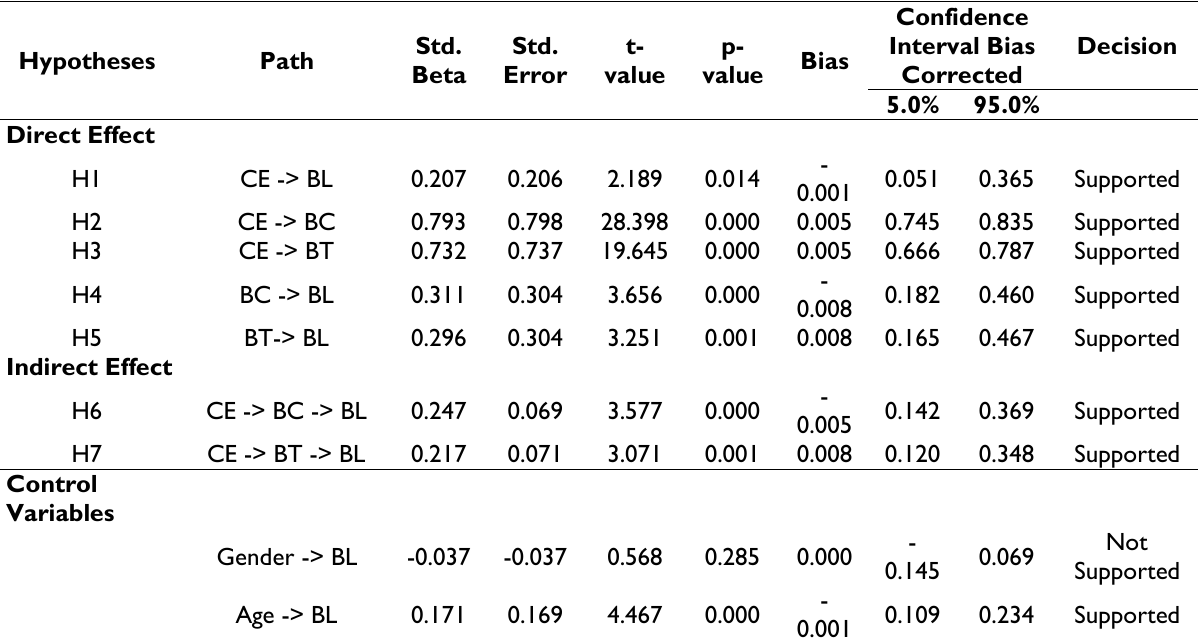
Table 5. Summary of Hypotheses Testing